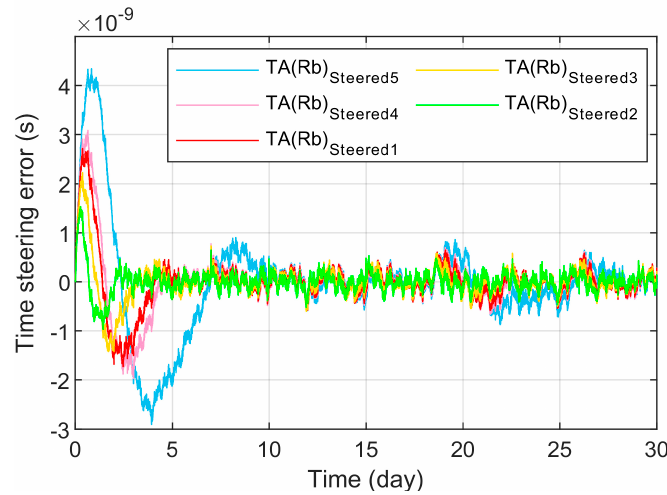
Figure 12. The steering error under the selection of different parameters.